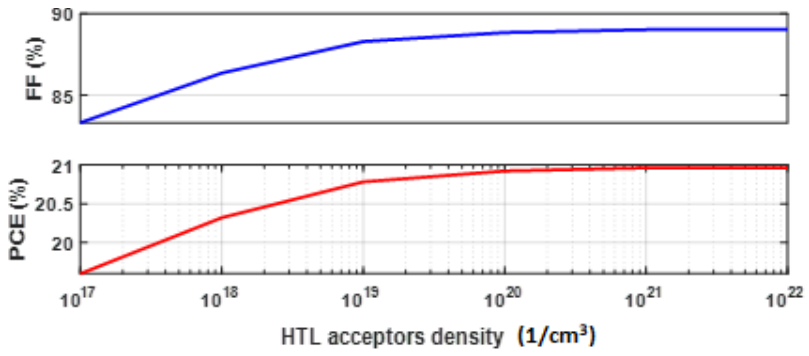
Figure 6. Effect HTL acceptor density on the performance parameters.